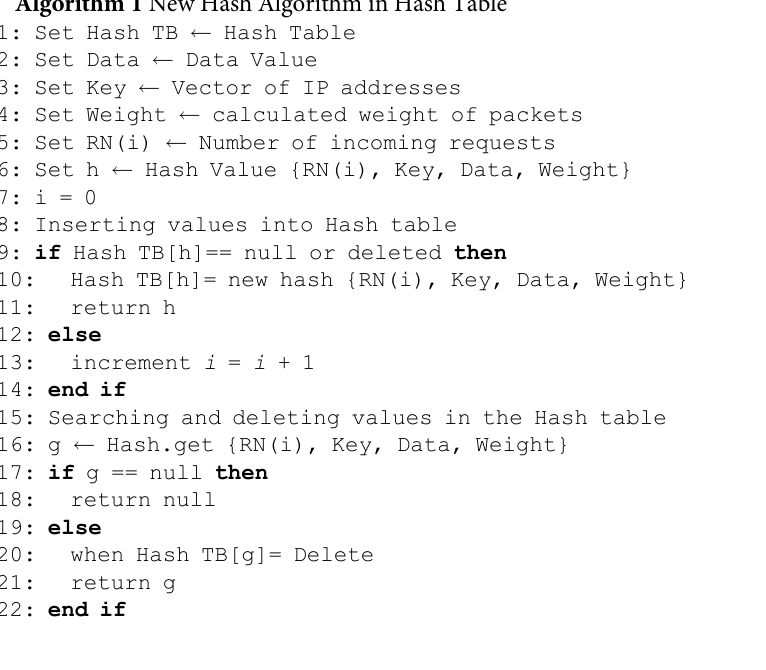
Algorithm 1 New Hash Algorithm in Hash Table